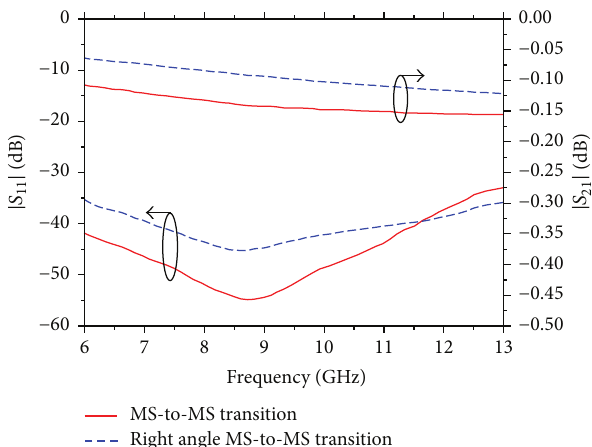
Figure 13: The measured 𝑆 -parameter of MS-to-MS transition with and without the matching